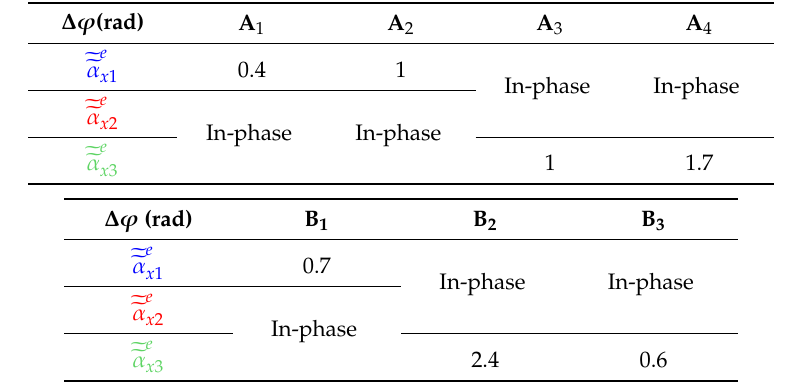
Table 1. The individual phase difference between the effective polarizabilities of the trimer array at each mode.